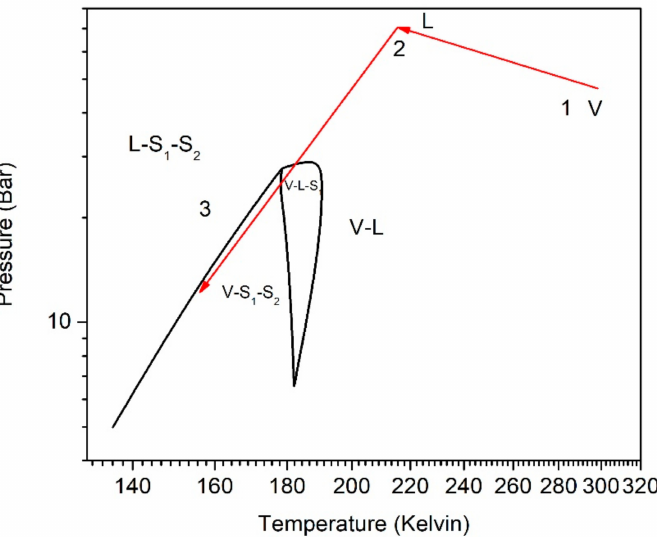
Figure 9. Illustration of the gas-sweetening unit using a TP phase diagram for case 2. Point 1 is the sour gas feed, point 2 is sour gas after being pressurized and cooled, and point 3 represents the product for which the sweet gas is separated in the vapor